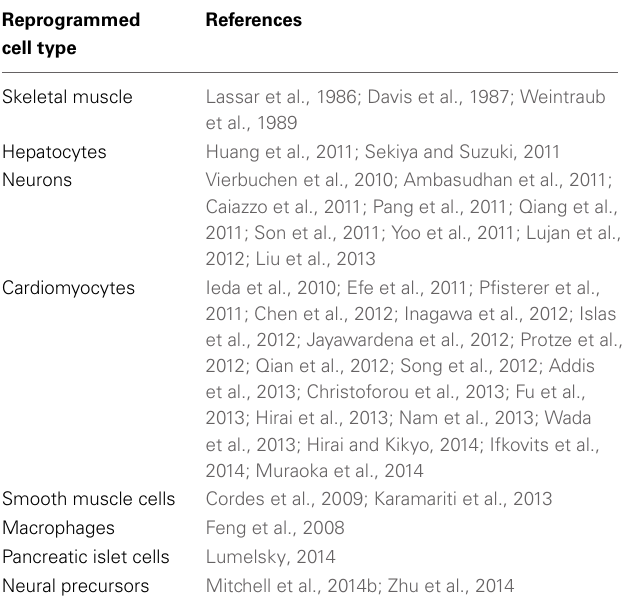
Table 1 | Reports of direct reprogramming of